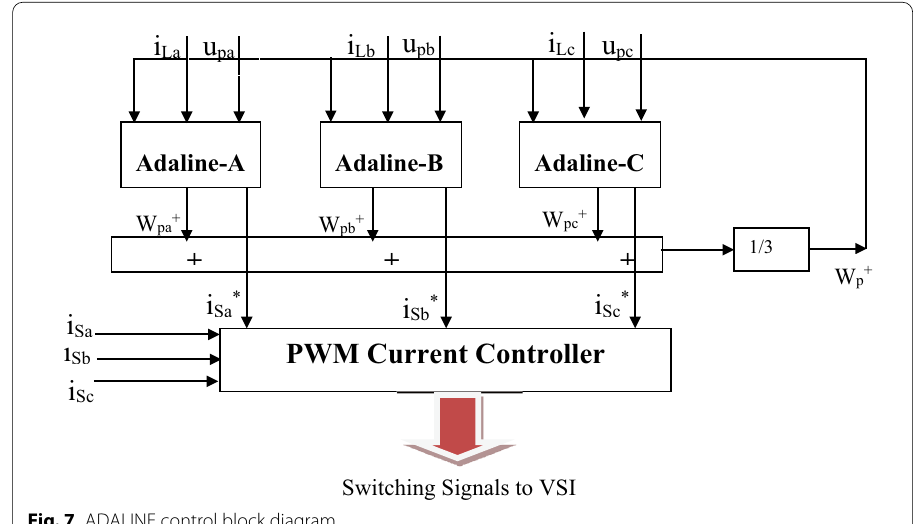
Fig. 7 ADALINE control block